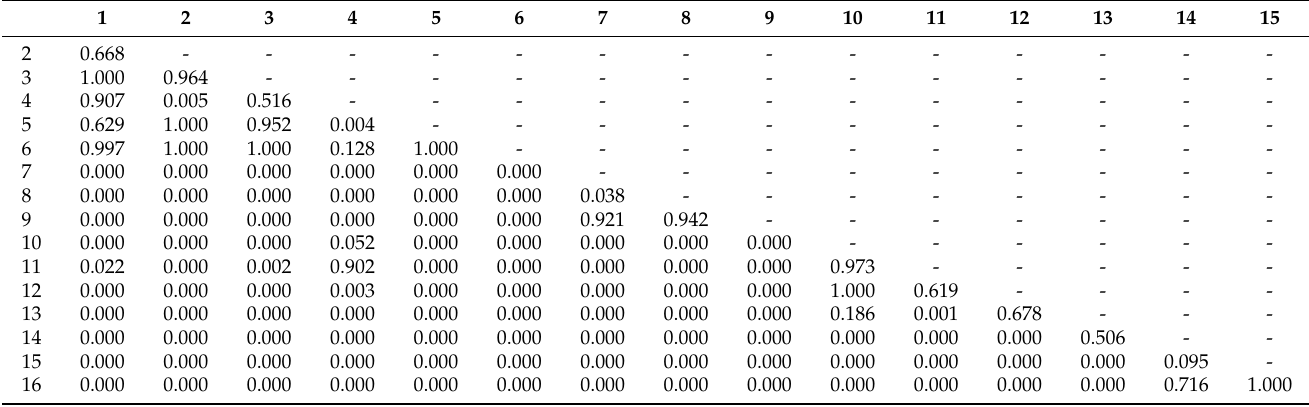
Table A3. p -values obtained from the Nemenyi test applied to the SSIM results. Row/Column names are listed in Table